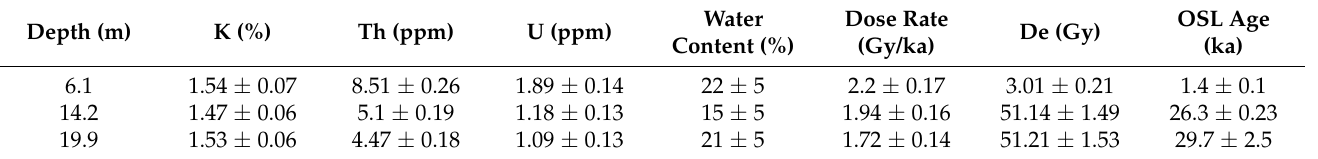
Table 1. The age–depth of core